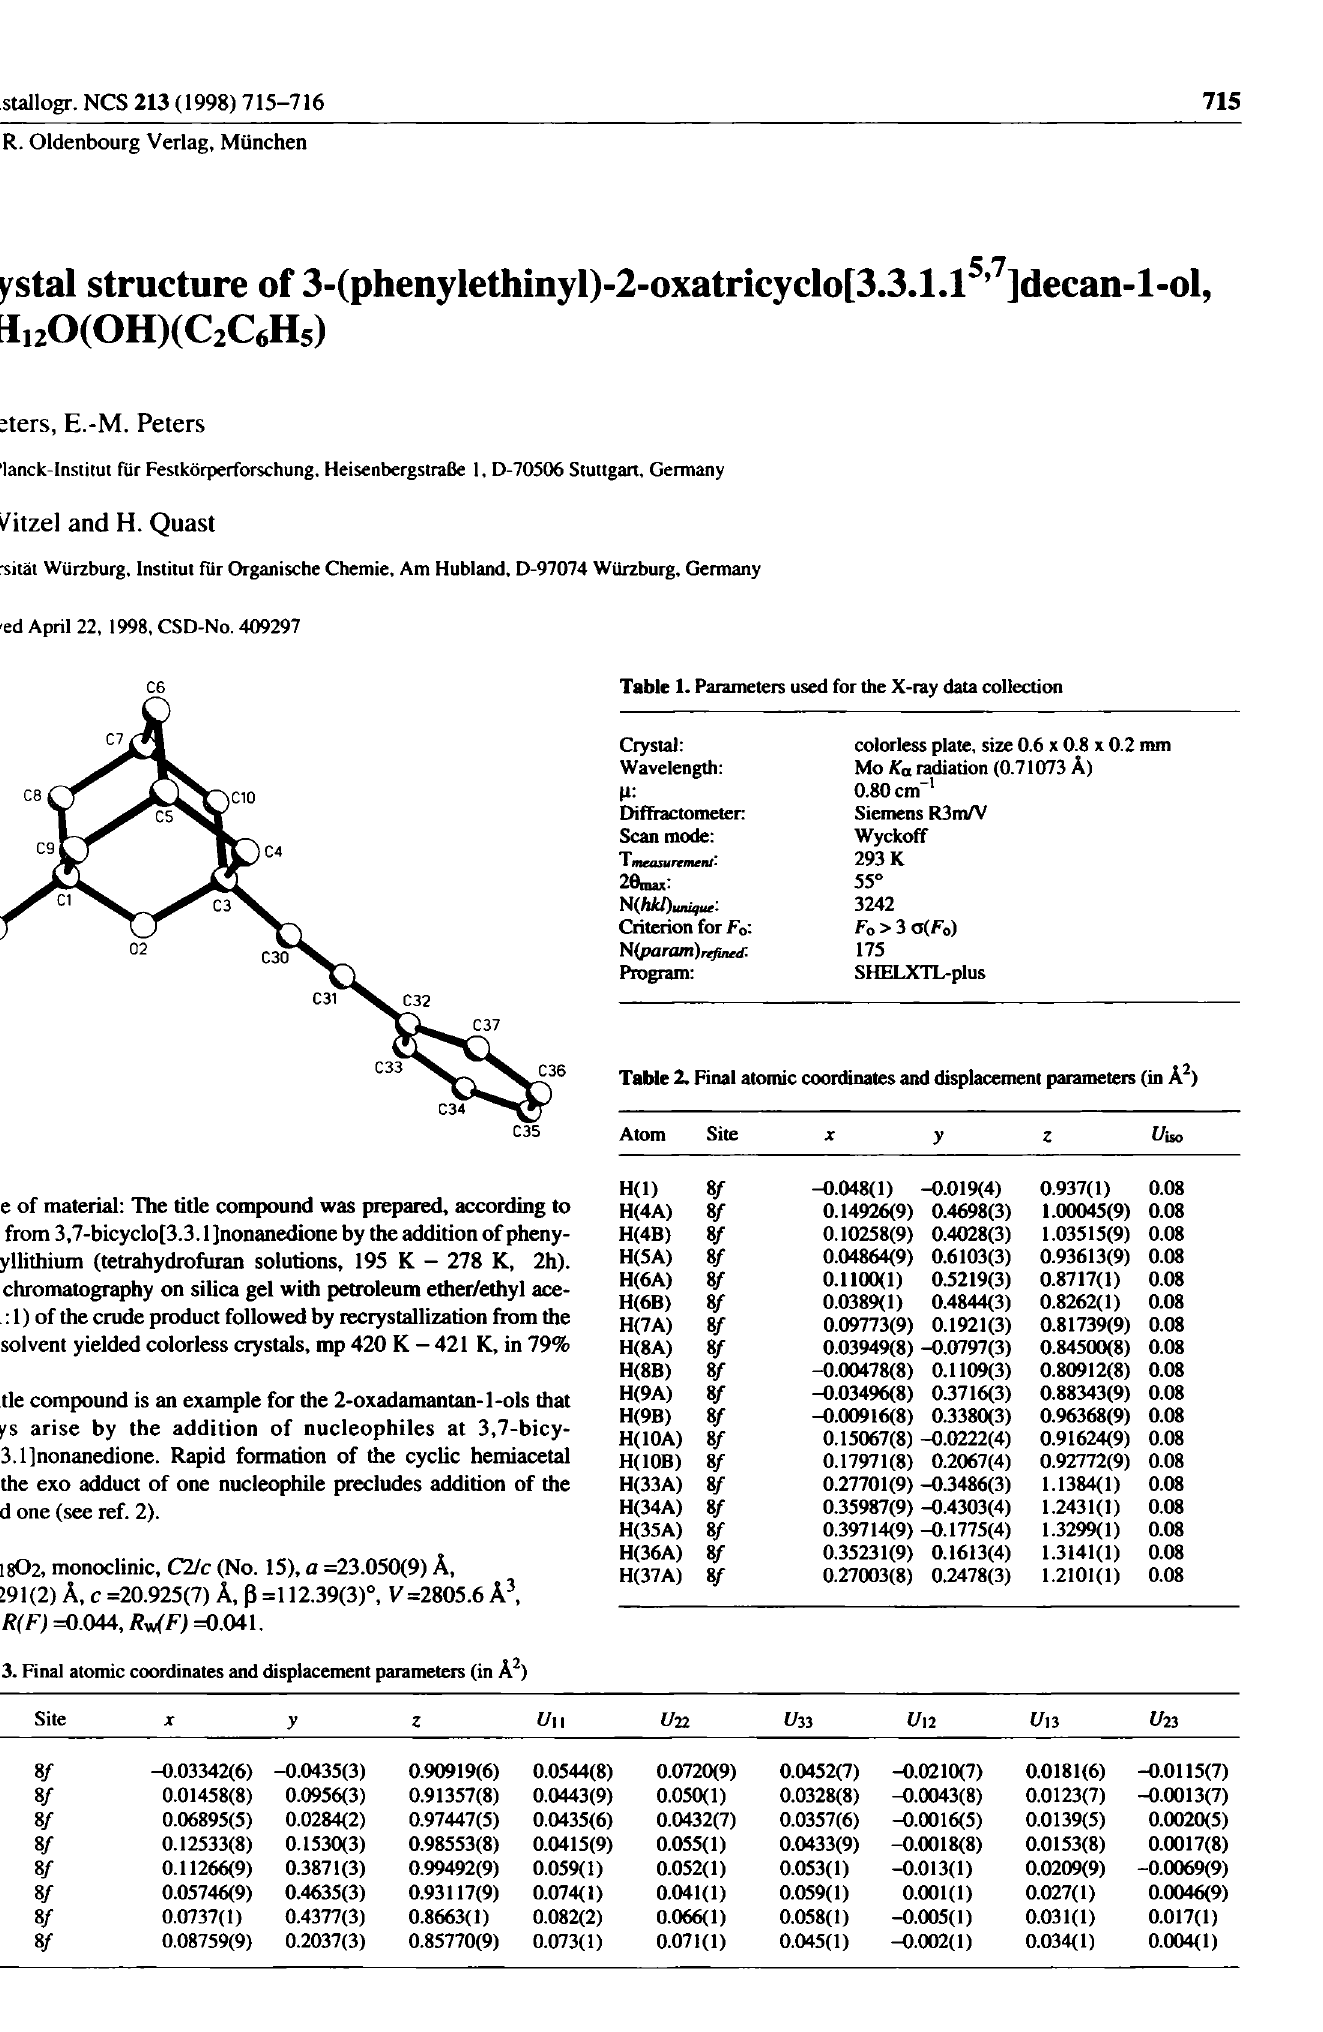
Table 3. Final atomic coordinates and displacement parameters (in Л^)